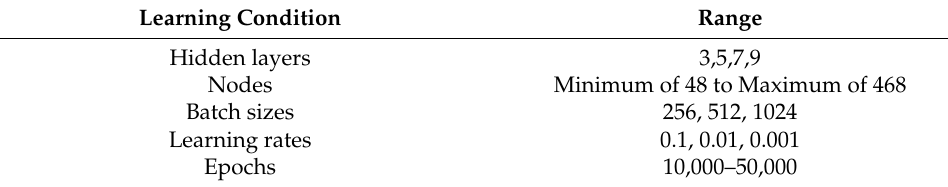
Table 5. Learning